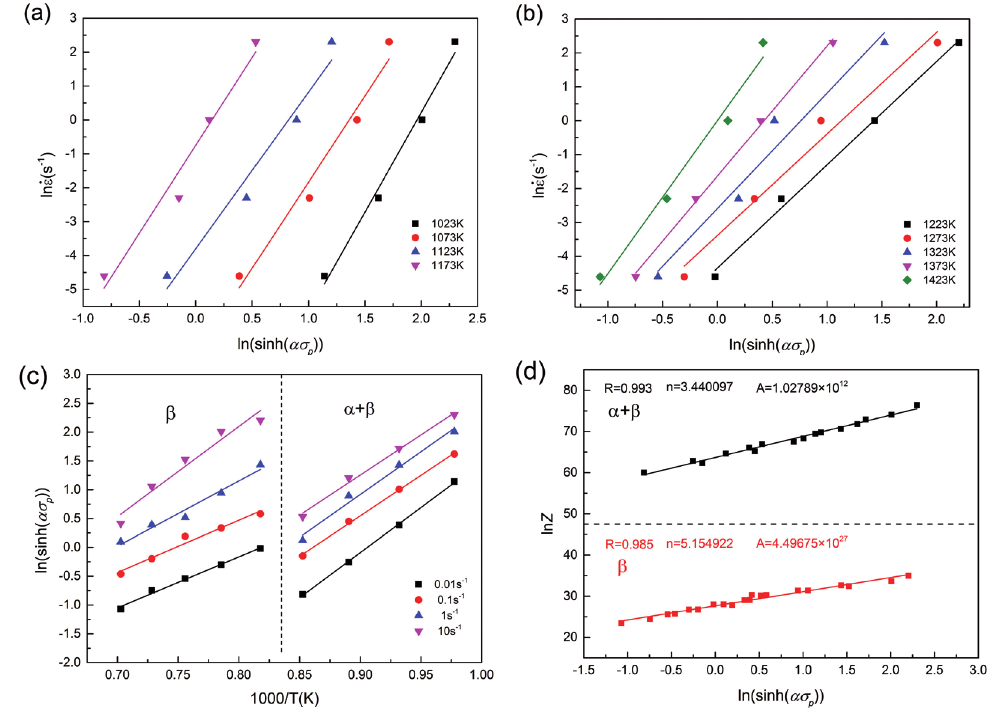
Figure 5: Plots of (a) ln f o versus ln(sinh( ασ )) in dual-phase field, (b) ln f o versus ln(sinh( ασ )) in β-phase field, (c) (1000/T) versus ln(sinh( ασ )) and (d) ln(sinh( ασ )) versus lnZ.